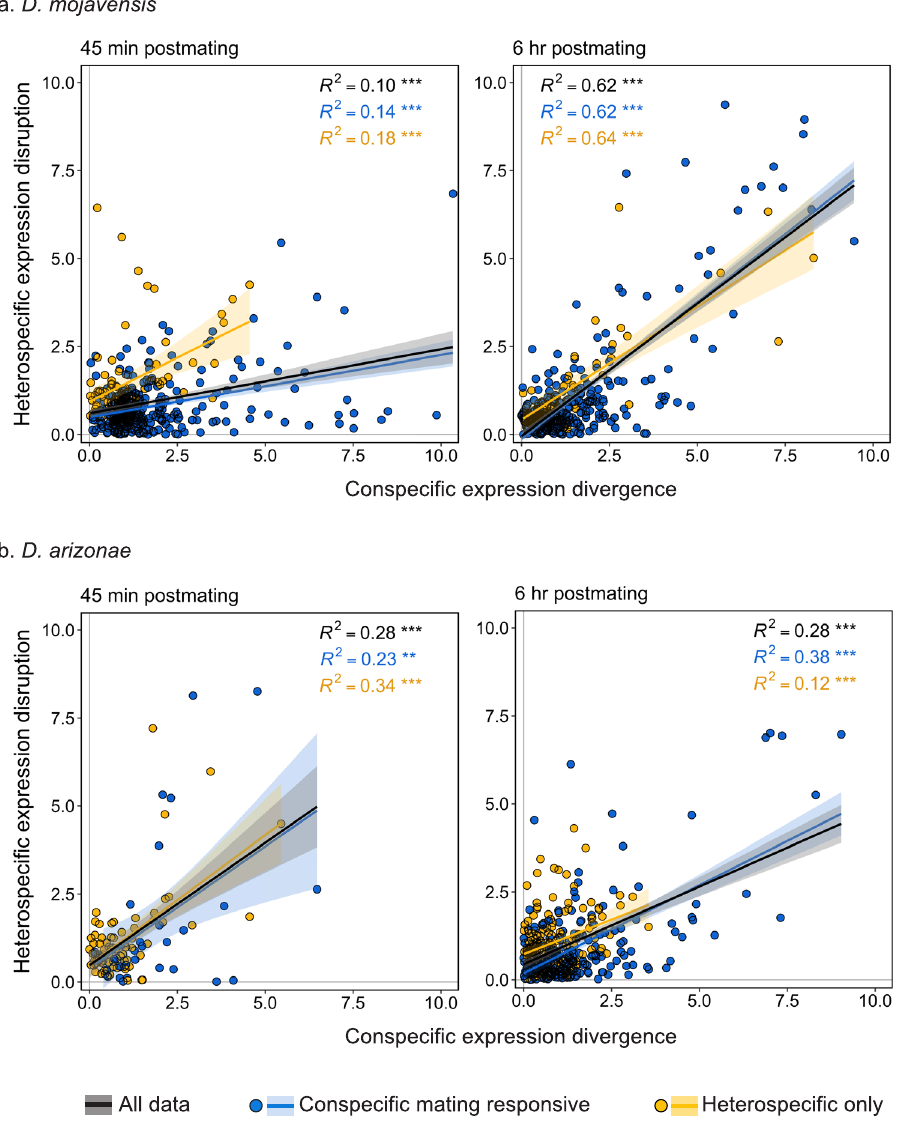
Fig. 8 Relationship between postmating conspeci fi c expression divergence and the level of heterospeci fi c disruption for conspeci fi c-responsive DE genes. Scatterplots show the relationship between postmating conspeci fi c divergence (e.g., D. mojavensis conspeci fi c expression divergence = |conspeci fi c D. arizonae − conspeci fi c D. mojavensis | ) and the level of heterospeci fi c disruption ( e.g ., heterospeci fi c disruption in D. mojavensis = |heterospeci fi c D. mojavensis − conspeci fi c D. mojavensis | ) for a D. mojavensis and b D. arizonae . All DE genes detected in con- or heterospeci fi c crosses at 45 min and 6 h postmating are included (FDR α = 0.05). Genes colored in blue are all conspeci fi c mating responsive genes. Genes colored in yellow are those that were DE in the heterospeci fi c cross but not the conspeci fi c cross ( “ heterospeci fi c only ” ). Pairwise Pearson ’ s R 2 correlation coef fi cients and linear method trend-lines (with 95% con fi dence intervals shaded) are shown. The black regression line is fi tted through all the data (blue and yellow combined). P -values of correlations are noted: ** P < 0.01, *** P < 0.001, ns not signi fi